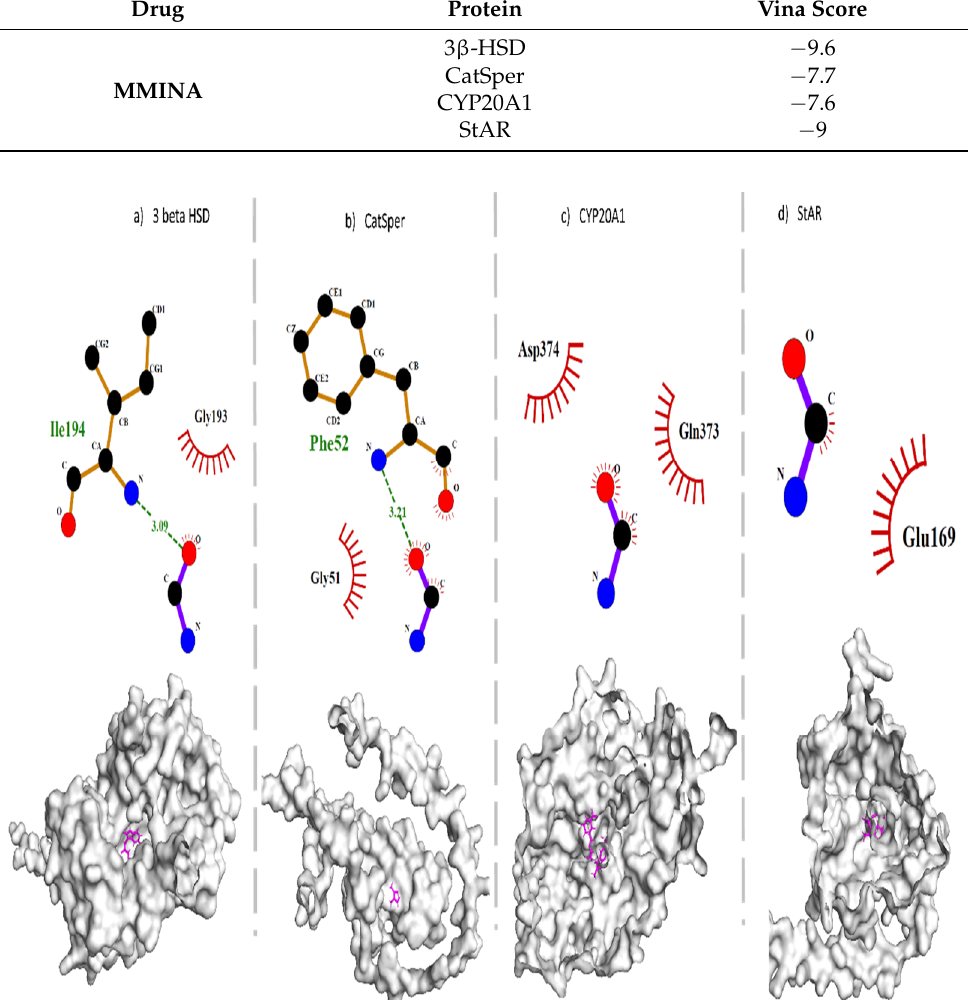
Figure 8. Molecular interactions between MMINA and 3 β -HSD, CatSper, CYP20A1, and StAR. ( a ) MMINA-3 β -HSD and ( b ) MMINA-CatSper complex has one hydrophobic interaction and one hydrogen bond, whereas hydrophobic interactions predominated in ( c ) MMINA-CYP20A1 and ( d ) MMINA-StAR complex. Semi-circles in red color depict hydrophobic interactions, green dotted lines show hydrogen bonding, and green numbers indicate the distance between hydrogen-bonded ligand and amino acid. Purple lined structure denotes ligand, while orange line structures represent amino acids. The surface view of the protein and ligand complex is shown below the 2D figure. Ligand is indicated with purple color.